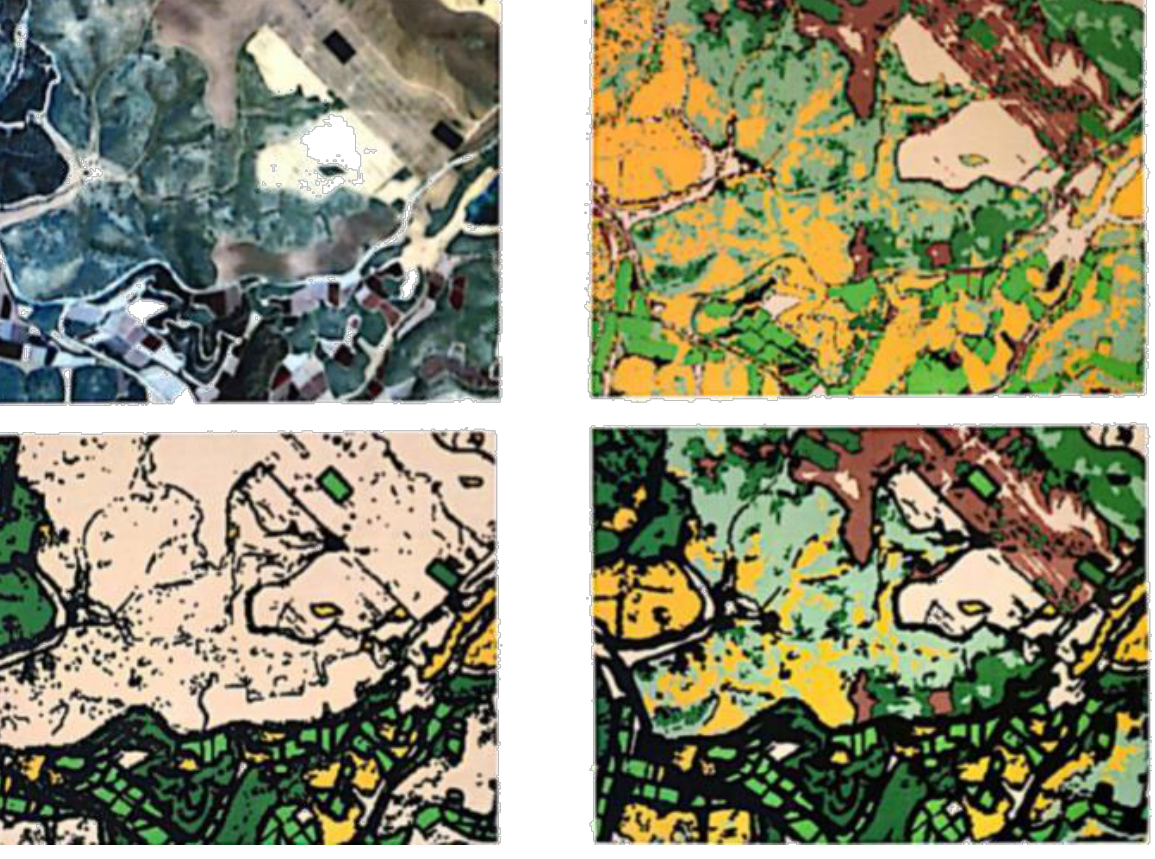
Figure 5 : Classification results for one of the test areas. Original image (top left), edges based image classified per-object with ML classification (bottom left), ISODATA unsupervised classification for the original image (top right), final research result – edges based classified image including completion of missing areas using ISODATA (bottom right)